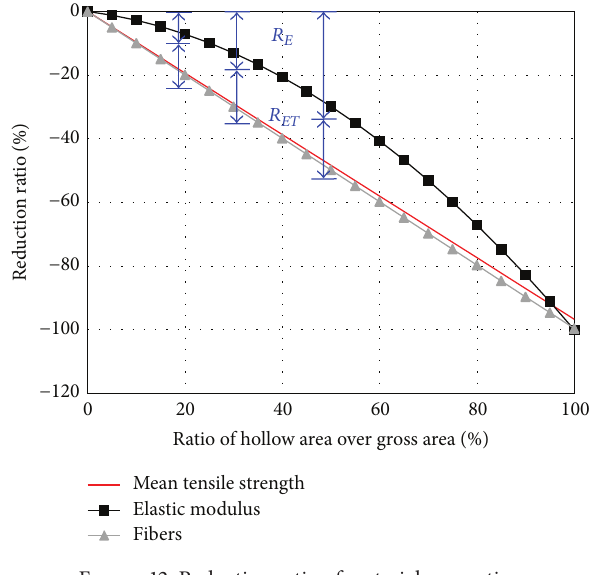
Figure 12: Reduction ratio of material properties.